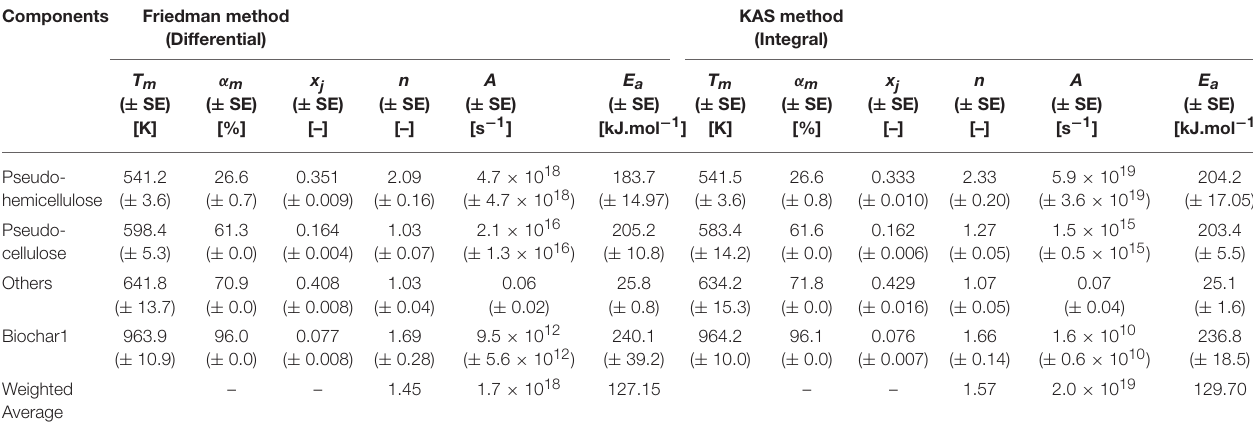
TABLE 8 | Thermal characteristics of the pseudo-components of Turbinaria ornata pyrolysis.